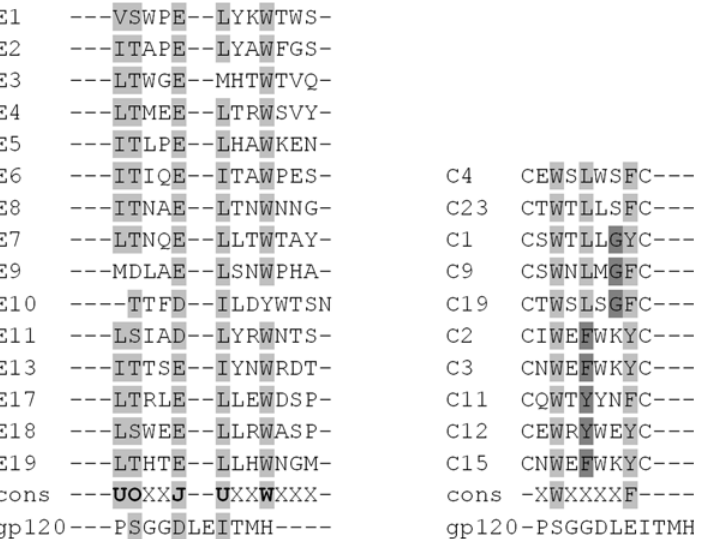
Fig 2. Alignment of the peptides from the phage clones showing the highest binding strength with VRC01 in dot blot with fragment 365 – 371 of gp120. Amino acid residues that correspond to the consensus sequence are marked by grey.